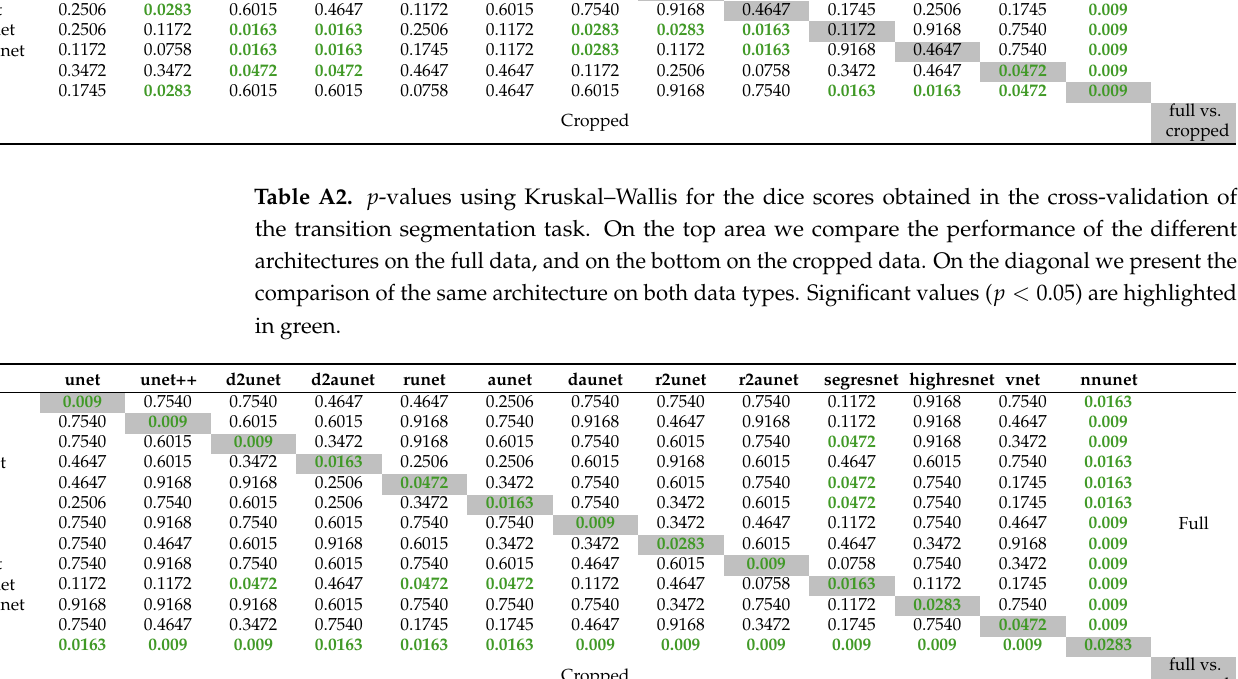
full vs. cropped